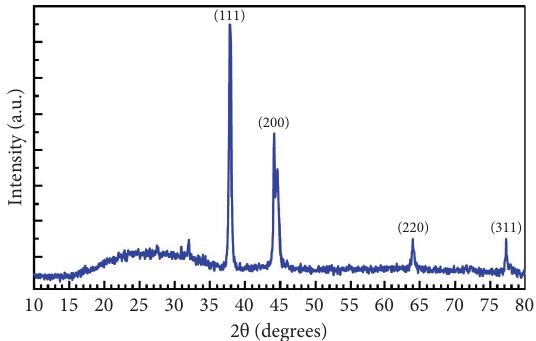
Figure 2: XRD pattern of AgNPs using N. sativa .